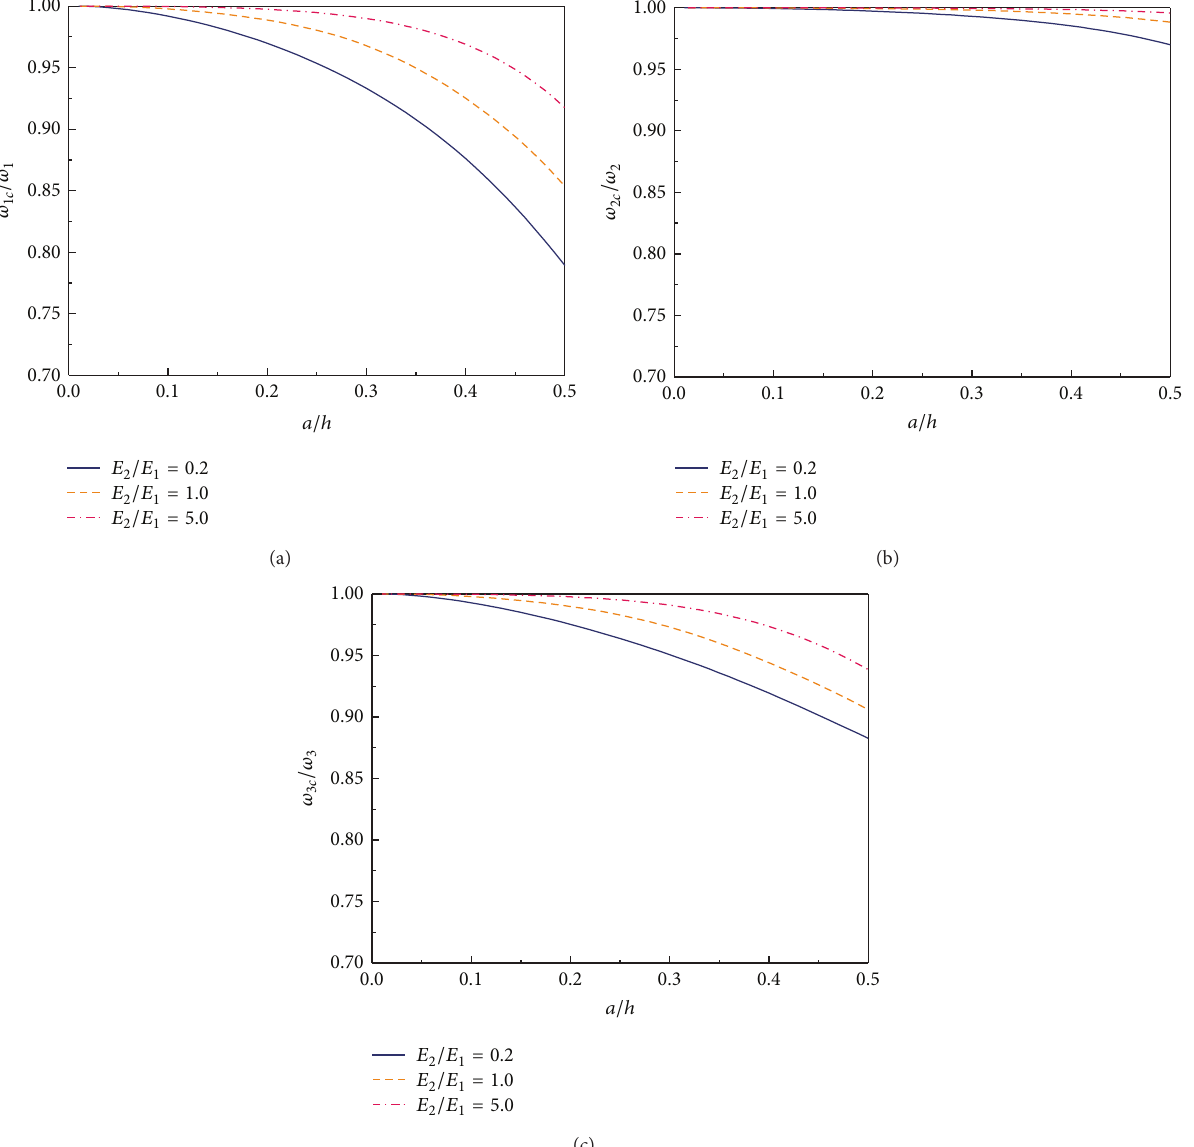
frequency attenuation for beams with smaller slenderness ratio, which indicates that the natural frequencies of beams with lower slenderness ratios are more sensitive to